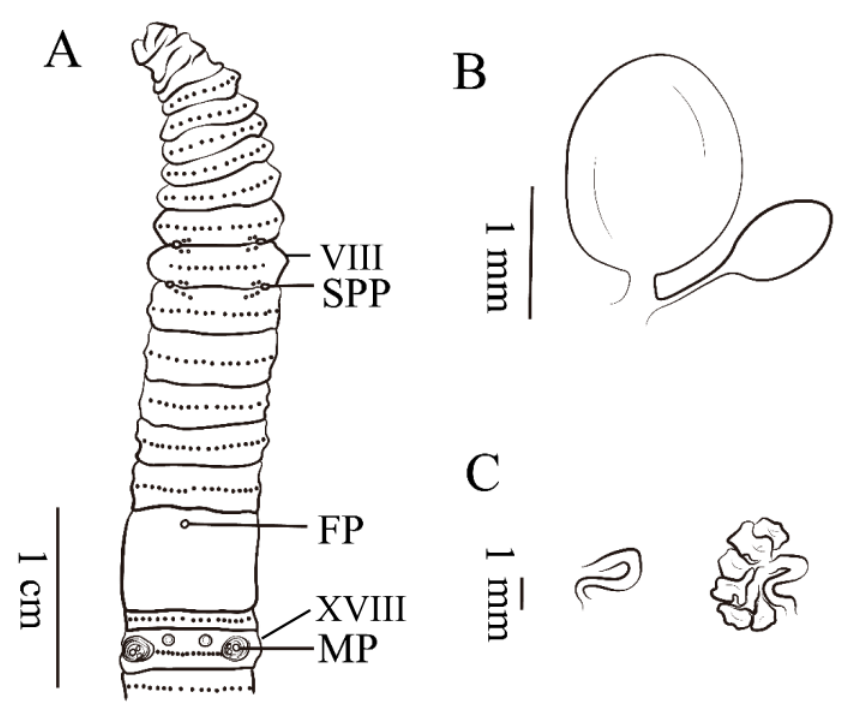
Figure 8. ( A ) Ventral view showing spermathecal pores, female pores and male pores of A.